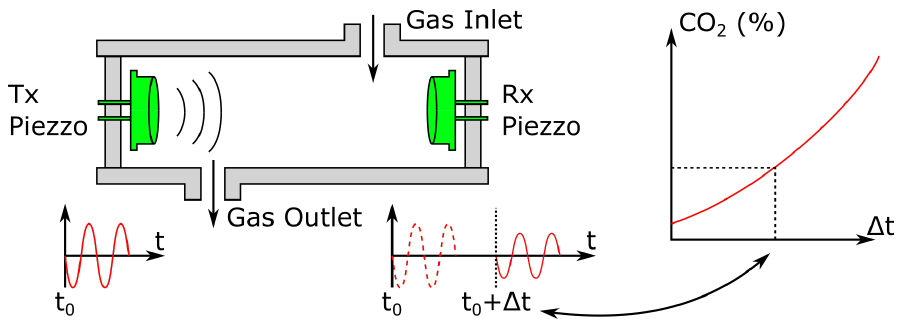
Figure 10. Outline schematic of a time of flight CO 2 sensor as described by Joos et al. [245]. Two ultrasound (40 kHz) transducers—emitter (Tx) and receiver (Rx)—are placed at both ends of an acoustic chamber which may consist in a simple tube. A burst of ultrasound is emitted at t 0 (on the left ) and arrives at t 0 + ∆ t at the receiver (on the right ). The ∆ t value can then yield the percentage of CO 2 in the gas mixture using velocity-based